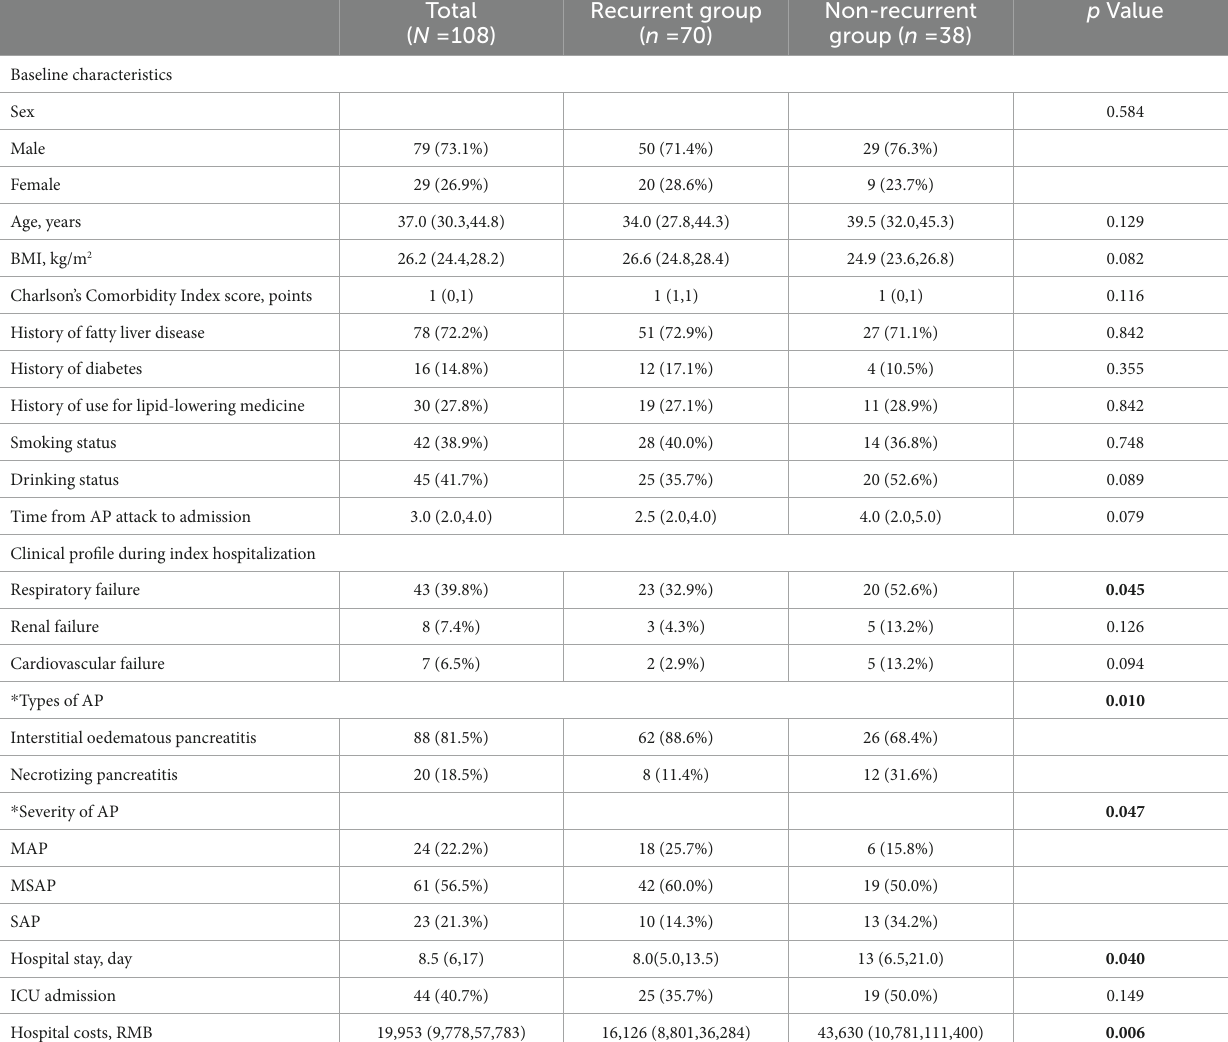
TABLE 1 Baseline characteristics and clinical profile during index hospitalization of patients with